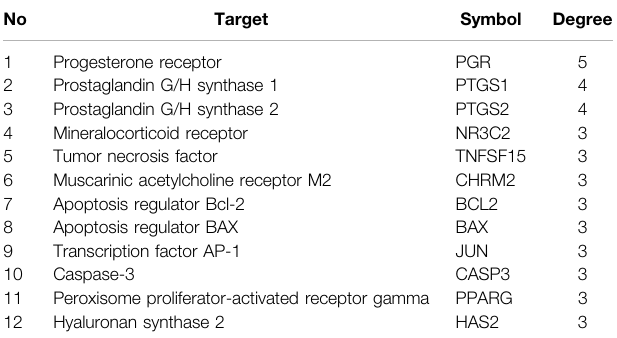
TABLE 3 | Top 12 high degree genes in the